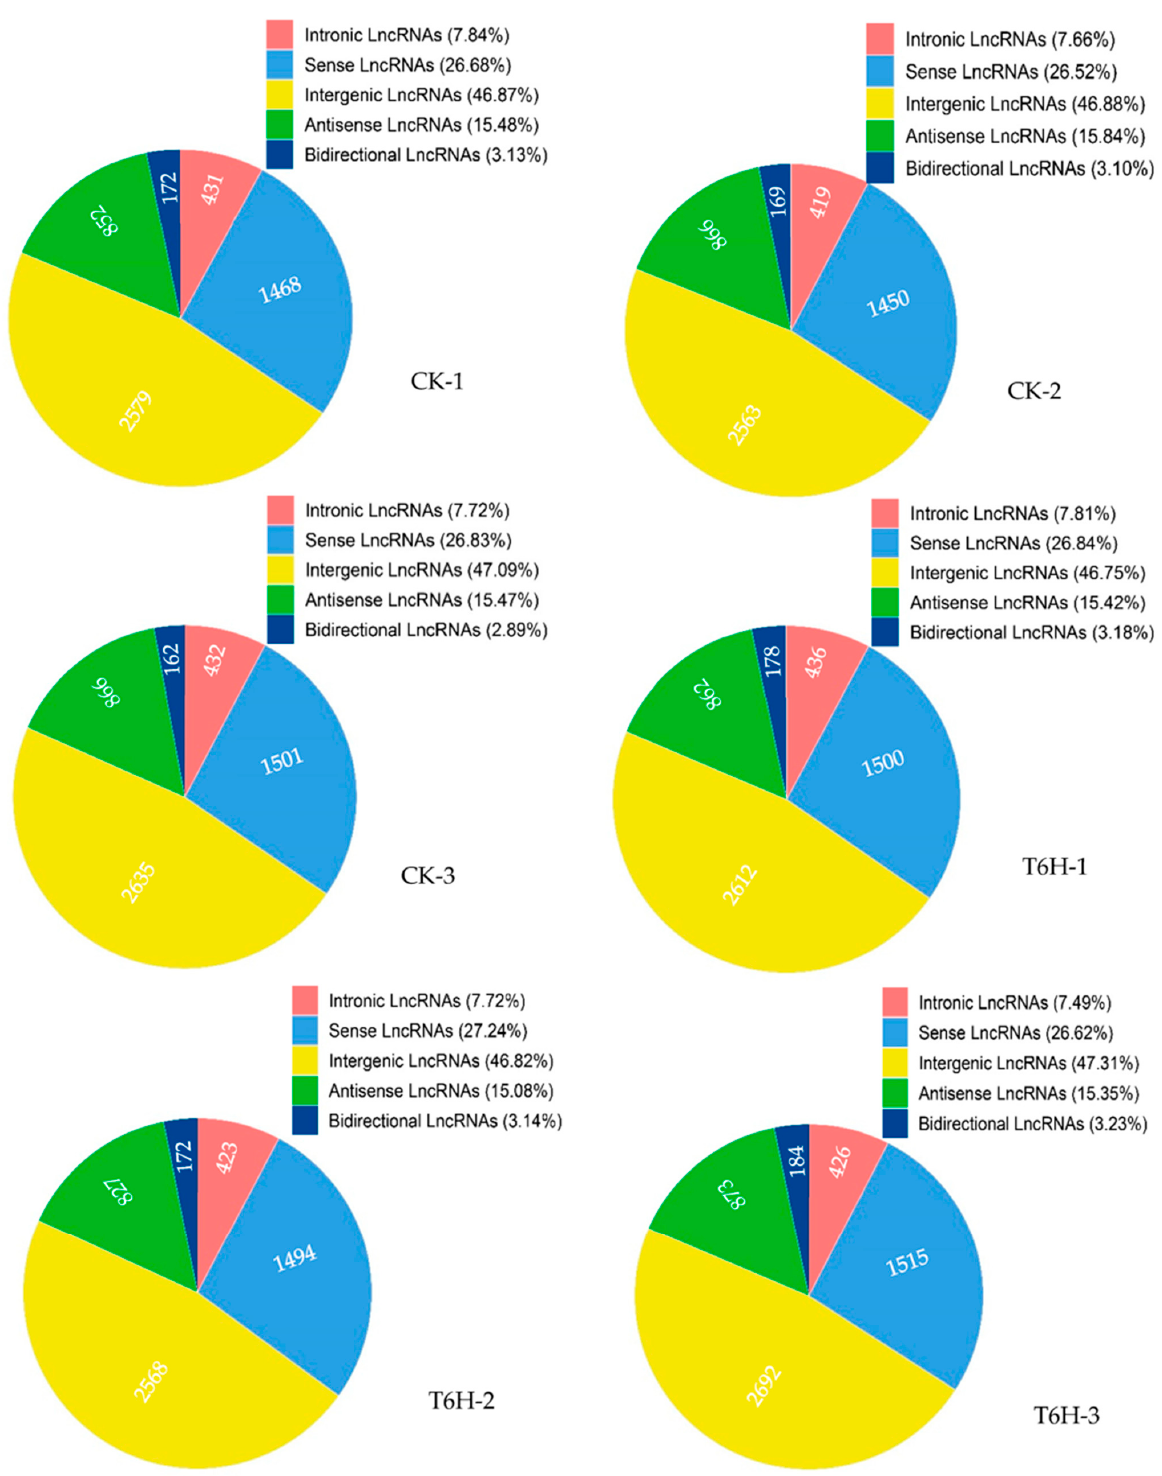
were divided into five categories: intergenic lncRNA (yellow), intronic lncRNA (red), bidirectional lncRNA (dark blue), sense lncRNA (light blue), and antisense lncRNA (green). Figure 2 shows that intergenic lncRNA was the largest component, accounting for almost half of all lncRNAs in the SA-treated and control leaves.